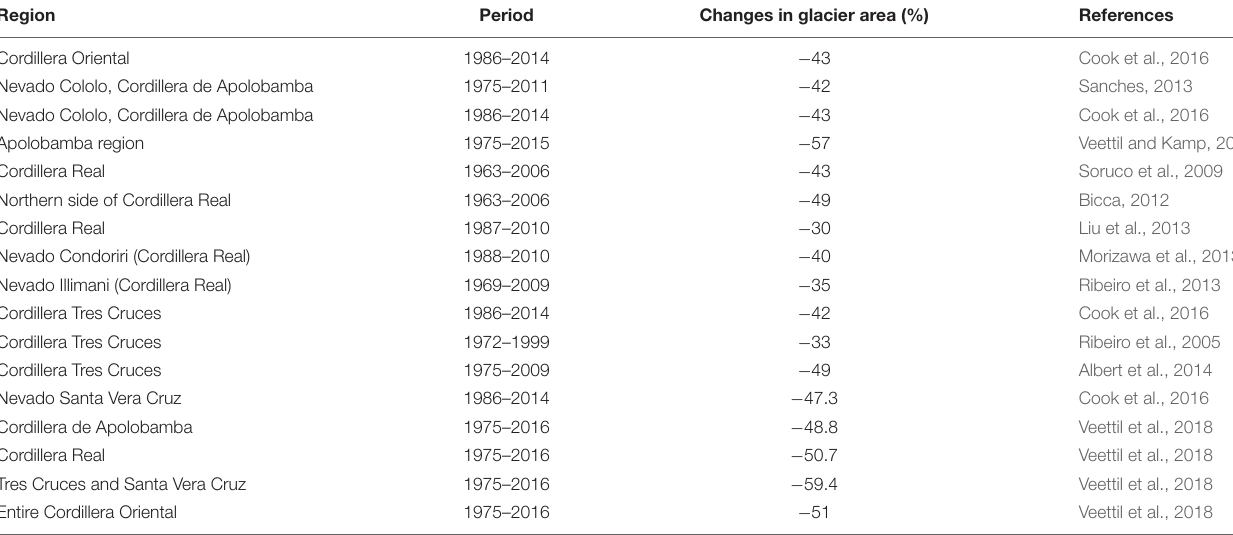
TABLE 1 | Compilation of studies based on aerial photographs and/or satellite imagery showing the recent glacier changes in Bolivia. Region Period Changes in glacier area